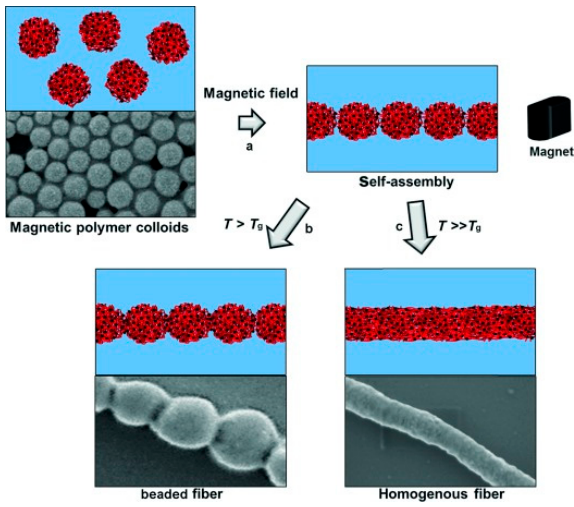
Figure 10. Magnetic self ‐ assembly ( a ) and fusion ( b,c ) of magnetic polymer colloids in water.